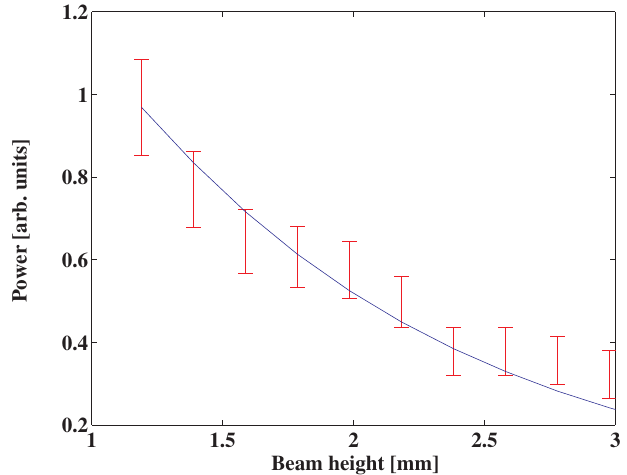
FIG. 2. (Color) Measured power vs beam height for (cid:5) (cid:2) 8 (cid:7) and (cid:2) 7 : 6 (cid:7) . The solid lines describes the theoretical calculation (cid:6) b for the parameters in Table